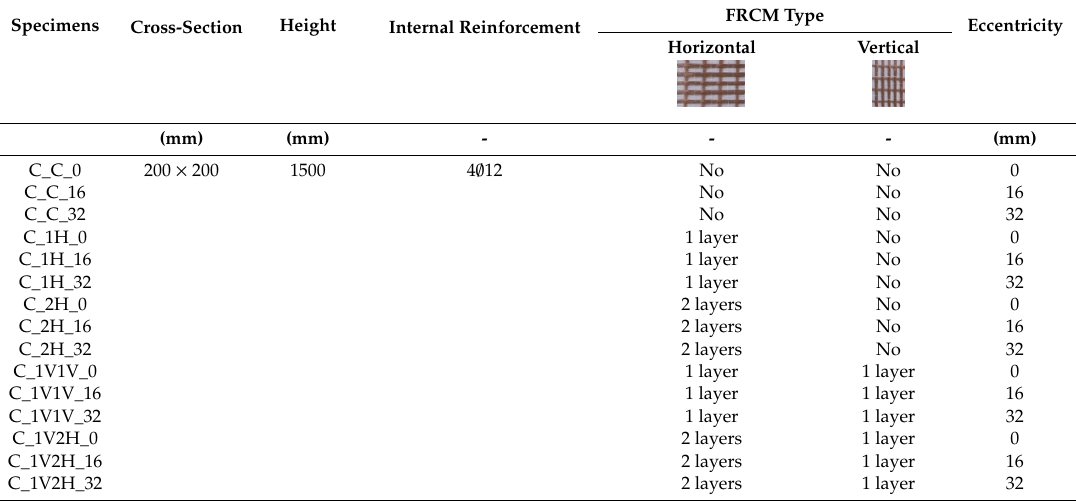
Figure 2. Cylindrical bearing used in the experiment: ( a ) e = 0; ( b ) e = 16 mm; ( c ) e = 32 mm.